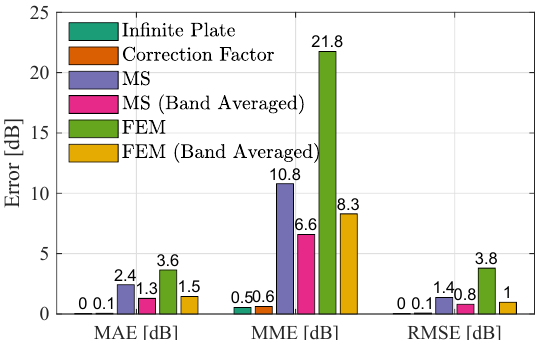
1.42.4 00 0.5 0.10.1 0.6